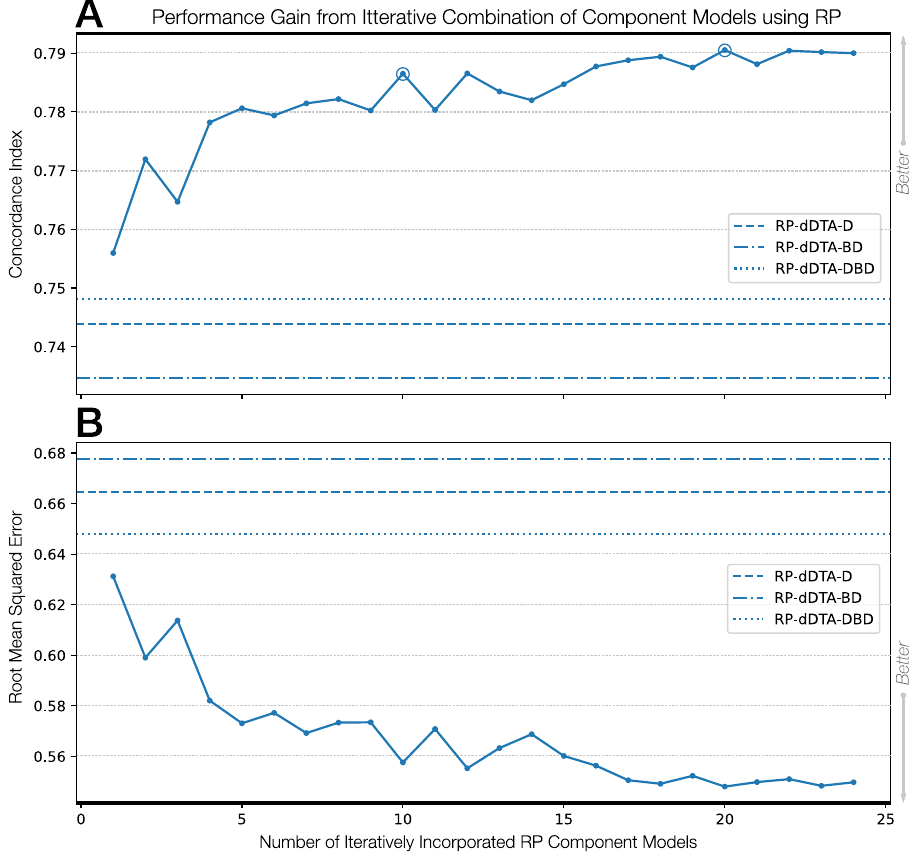
Figure 7. Experimental results over the DeepDTA-defined datasets when incrementally incorporating reciprocal perspective component models compared to the SOTA DeepDTA models. The top-performing combined models were circled in the figure (top-20 models) and the first (top-10 models) represent the performance of the proposed MUSDTI model even when the later combined models represent a marginally higher performance. We opted for the component model ensemble that represented the plateaued performance of component